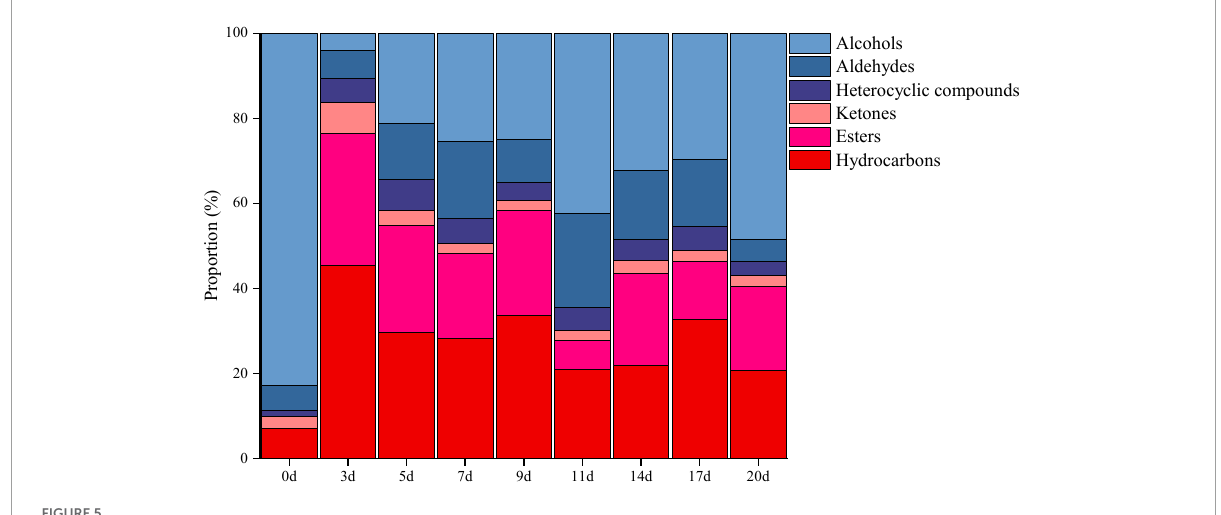
FIGURE5 Dynamics of the relative proportion of volatiles during the production of fermented minced peppers.